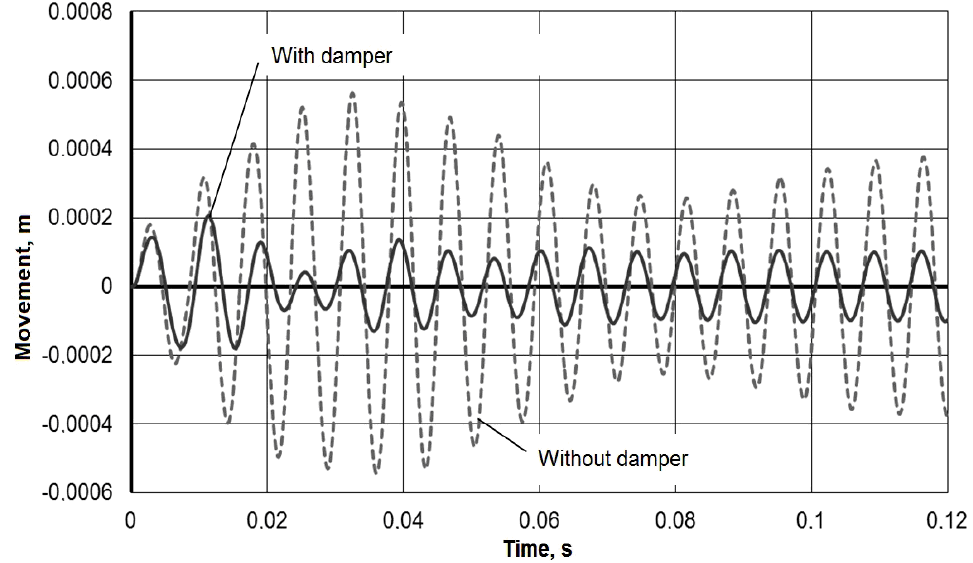
Figure 6. Frequency modes comparison.